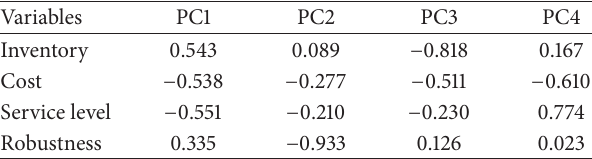
Table 10: Result of principle components.